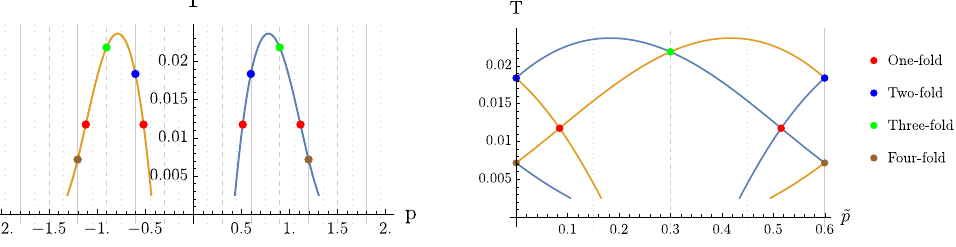
Figure 3 . Cartoon of the Brillouin zone folding using the instability curve of RN marginal modes as an example. Left panels show the extended BZ representation, right panels show the Bloch momentum in the periodic BZ at di(cid:11)erent wavevectors of the ionic lattice. Note that n-fold points are separated by distance in momentum space (cid:1) p = nk